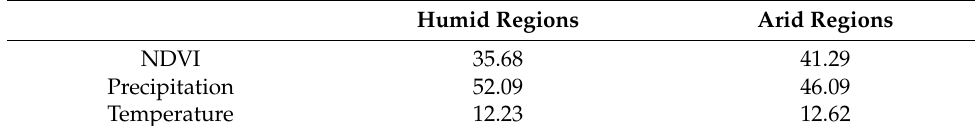
Table 1. Area percentage of dominant factors causing SM changes in humid and arid regions (%).